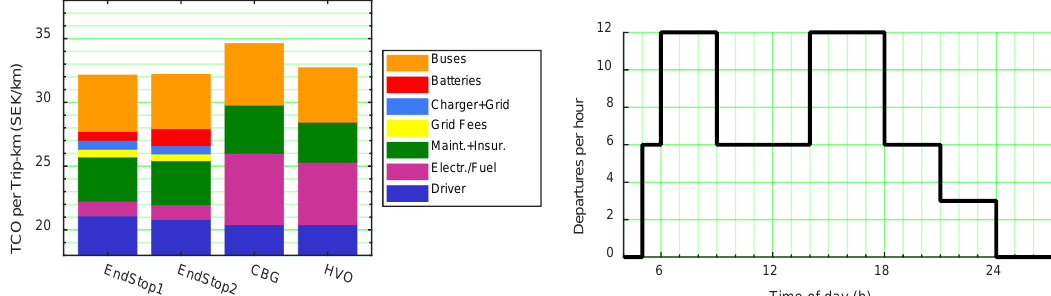
Figure 15. The cost per km for end-stop-charged and biogas (CBG) buses with cost parameters estimated for high production volumes. (Note that the y -axis starts at 18 SEK/km, so the driver cost is more than half the TCO).